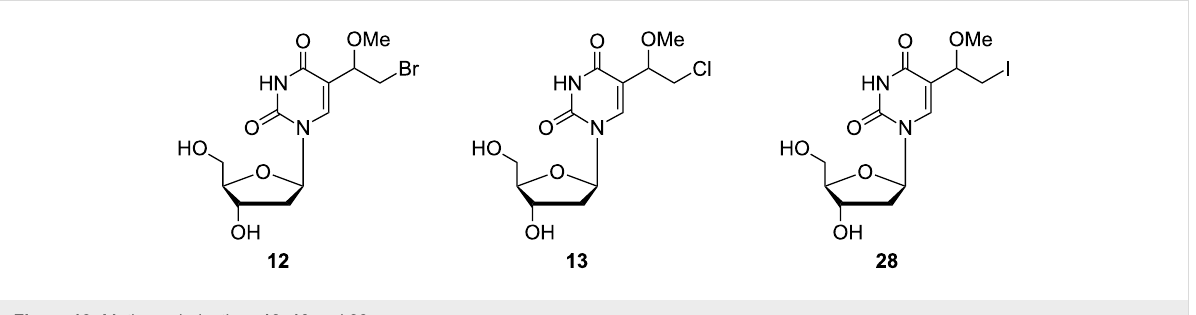
Figure 12: Methoxy derivatives 12 , 13 and 28 .